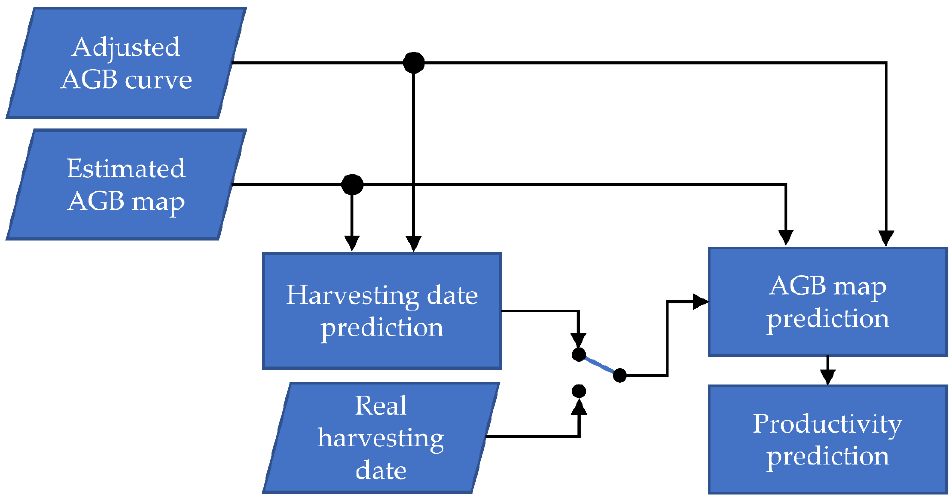
Figure 7. General diagram of the prediction methods.